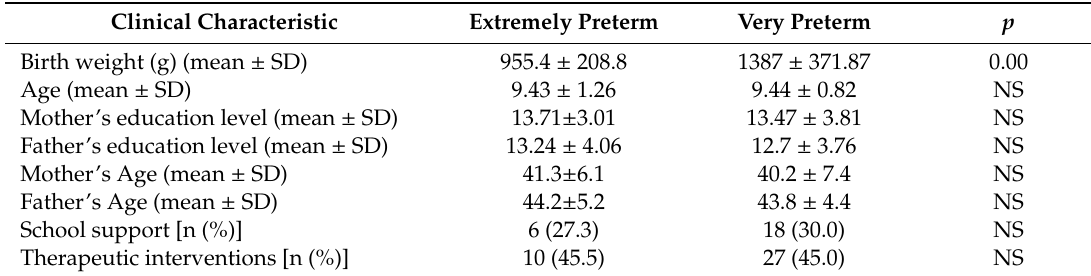
Table 1. Clinical characteristics of the preterm children enrolled in the